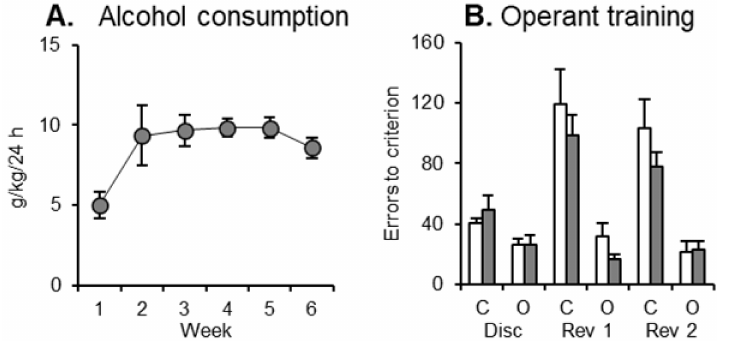
Figure 1. Experimental data. ( A ) Alcohol consumption (g/kg/24 h access period, mean+SEM) across the six-week alcohol access period. ( B ) Errors to criterion (mean+SEM) for discrimination session (disc), reversal 1 (rev 1), and reversal 2 (rev 2) sessions. Errors were divided into commission (C) or omission (O) errors. White symbols/bars represent the water group ( n = 12) and gray symbols/bars represent the alcohol group ( n =